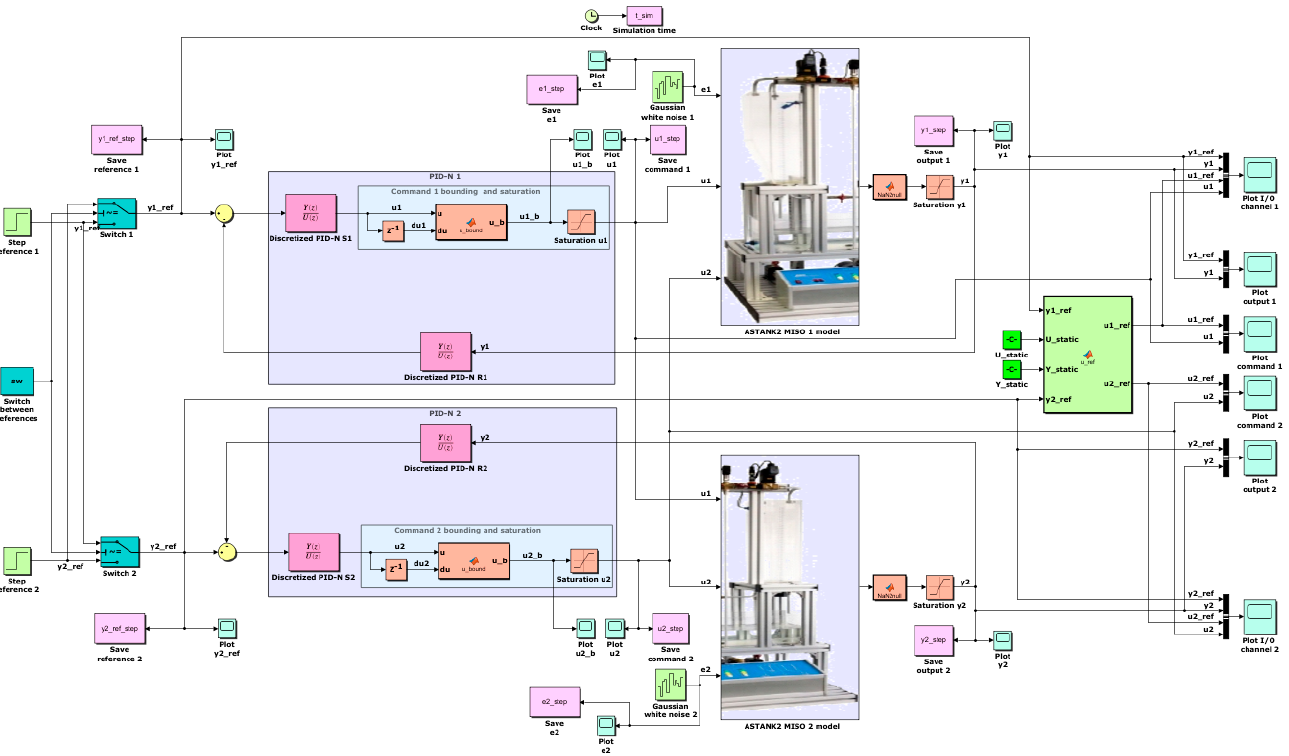
Figure 10. Closed loop PID-R-ASTANK2 SIMULINK model.